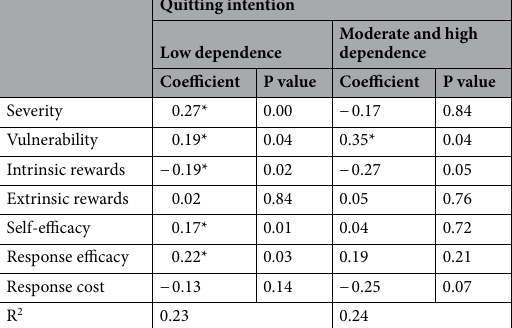
Table 3. Logistic regression models of the quitting intention regressed on the PMT variables by tobacco dependence. We controlled for sex, education attainment, alcohol drinking in all the models. *p < 0.05.